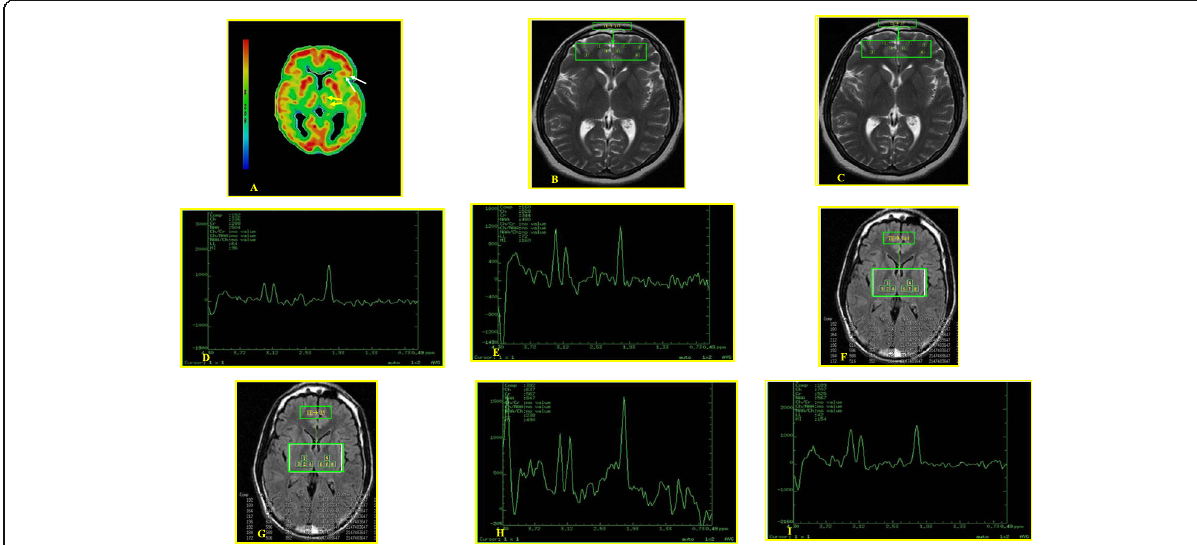
Fig. 2 a – i A 33-year-old female patient of non-lesional left frontal lobe FIAE The visual-based analysis of the axial PASL-MRI colour-coded cerebral perfusion map ( a ) demonstrates a focal hypoperfusion of the left frontal lobe (white arrows) and ipsilateral thalamus (yellow arrows). The estimated rCBF for right and left frontal lobes was 76.25 and 62.67 ml/100 g/min, respectively, with the calculated ASLAI% of 14.91%. Additionally, the estimated rCBF of the right and left thalami was 74.77 and 69.09 ml/100 g/min, respectively, with the calculated ASLAI% of 8.90%. The MV 1H-MRS picture maps of both frontal lobes and thalami, were obtained at a long TE of 144 ms ( b and f , respectively) and at a short TE of 35 ms ( c and g , respectively). The MRS spectra demonstrate increased MI/NAA, Glx/NAA and Glx/Cr, as well as decreased NAA/(Cho + Cr) ratios in the left frontal lobe ( e ) compared to the right frontal lobe ( d ), while the ipsilateral left thalamus ( i ), when compared to the contra-lateral right thalamus ( h ), showed decreased MI/NAA and NAA/(Cho + Cr), as well as increased Glx/NAA and Glx/Cr ratios. For right and left frontal lobes, these ratios were [NAA/(Cho + Cr) = 0.80 and 0.55 with %AF of 38.24%, MI/NAA = 0.20 and 1.27 with %AF of 14.56%, Glx/NAA = 1.33 and 1.58 with %AF of 17.18% and Glx/Cr = 1.30 and 1.53 with %AF of 16.25%]. These ratios for right and left thalami, respectively, are [NAA/(Cho + Cr) = 0.60 and 0.46 with %AF of 26.42%, MI/NAA = 0.38 and 0.27 with %AF of 33.85%, Glx/ NAA = 1.28 and 1.49 with %AF of 15.16% and Glx/Cr = 1.25 and 1.45, with %AF of